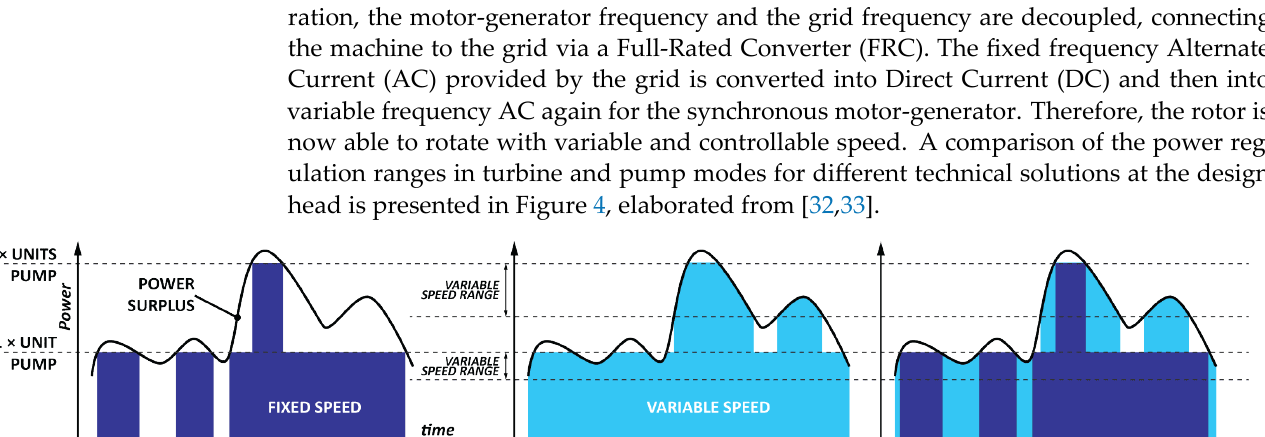
Figure 3. Power surplus utilisation with multiple units in pump mode (example with two units): Fixed-Speed units ( left ), Variable-Speed units ( center ), comparison ( right ).